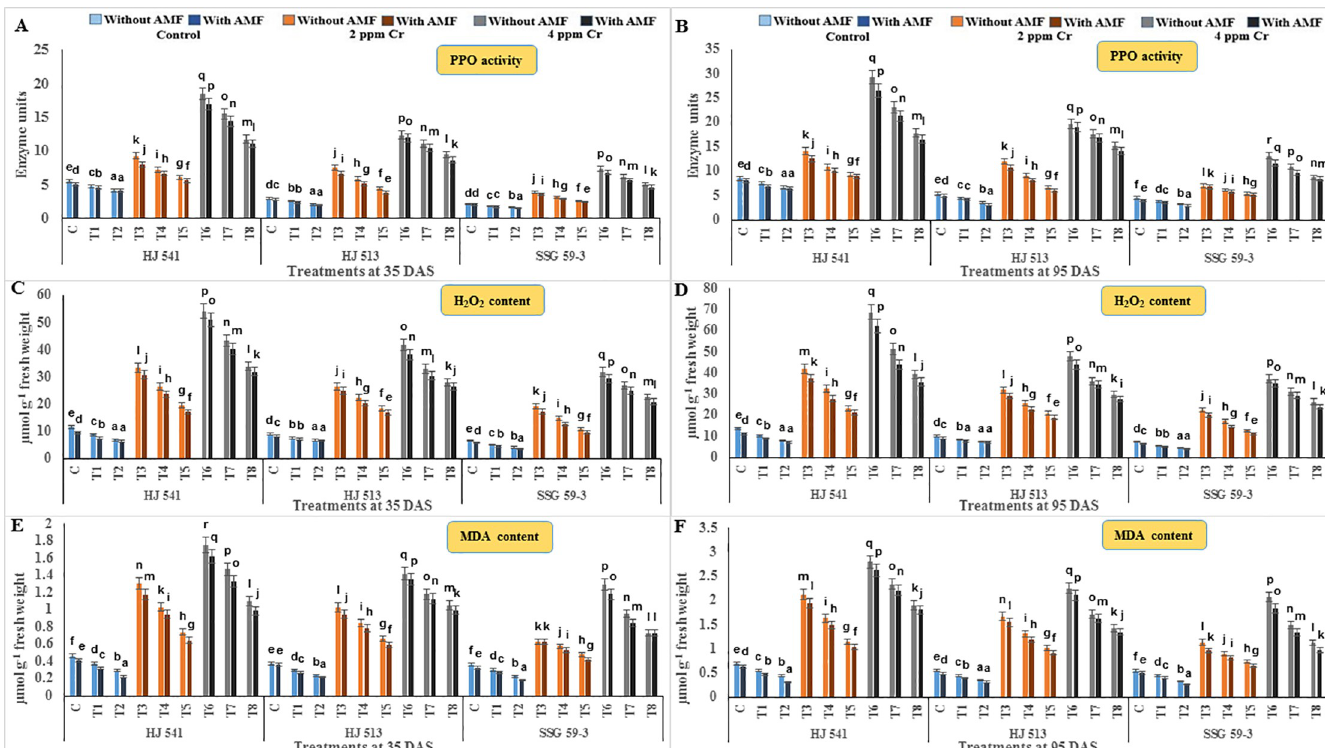
Fig 3. Effects on indices of oxidative stress viz . PPO activity (A and B), H 2 O 2 content (C and D) and MDA level (E and F) in different varieties of sorghum exposed to GB and AMF treatments under Cr toxicity at 35 & 95 DAS, respectively. Data are expressed as means of three replications with ± S.E., N = 3, from three independent experiments. Different letters above the bars in each column indicate significant differences among treatment means based on the least significant difference (LSD) test at P � 0.05.